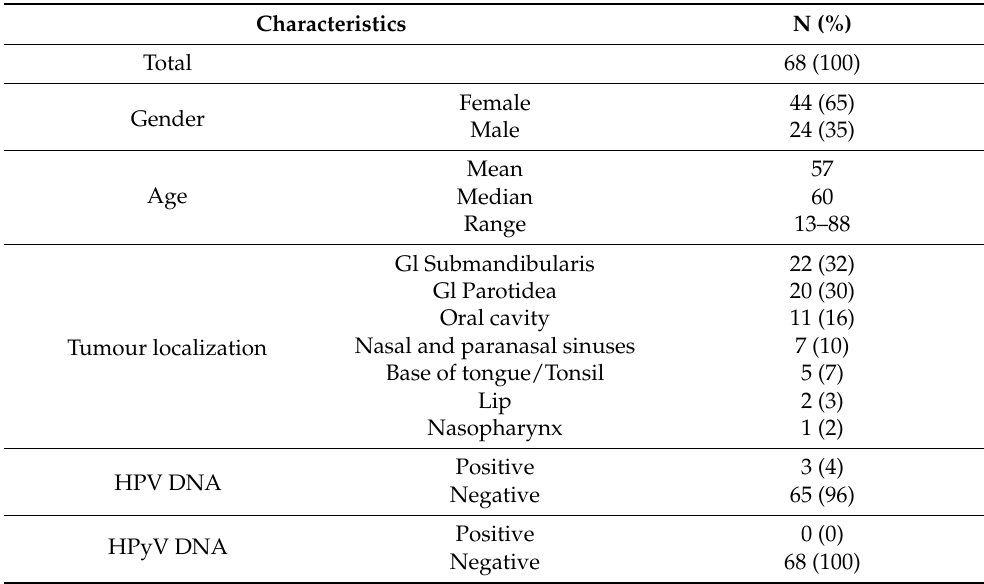
Table 1. Patients initially diagnosed with adenoid cystic carcinoma (AdCC), with patient and tumour characteristics.